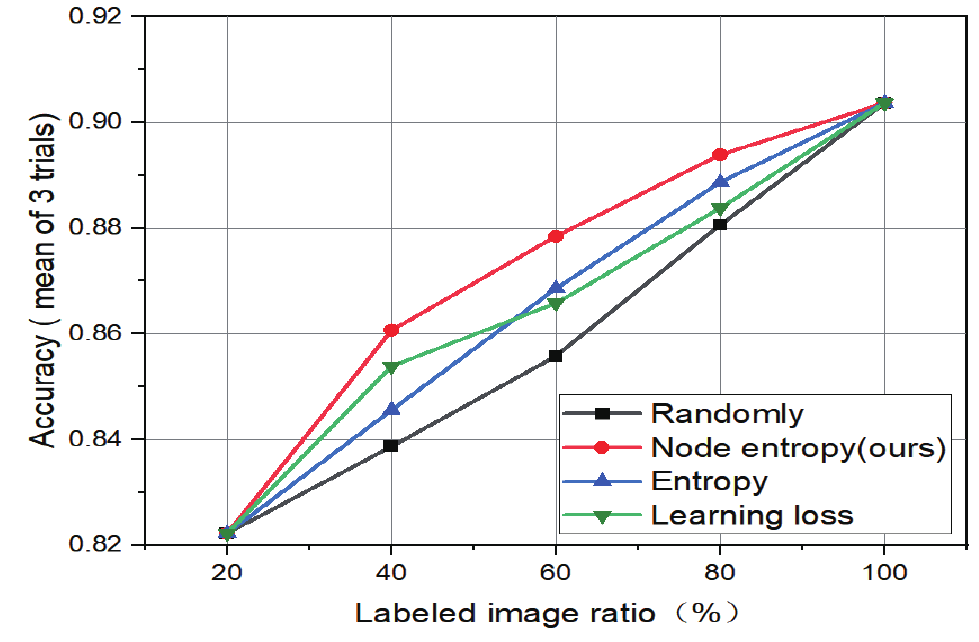
Figure 5. Comparative experiment on RSSCN7 dataset. Table 1. Ablation study on AID.